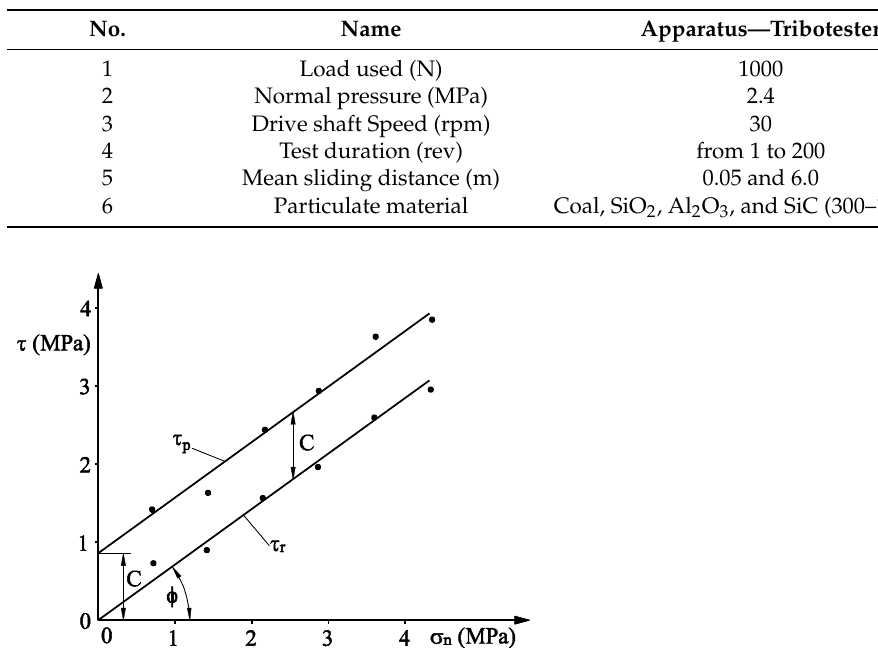
Table 1. Specification of the apparatus and experimental details.